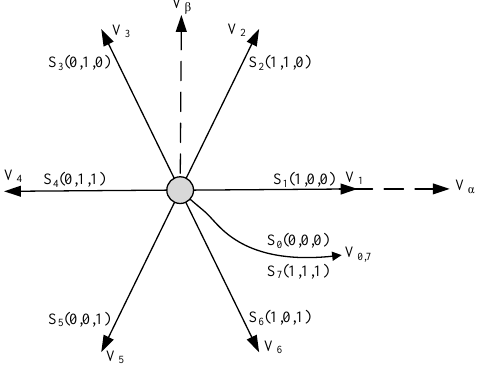
Figure 2. Voltage vectors generated by the inverter ( V i